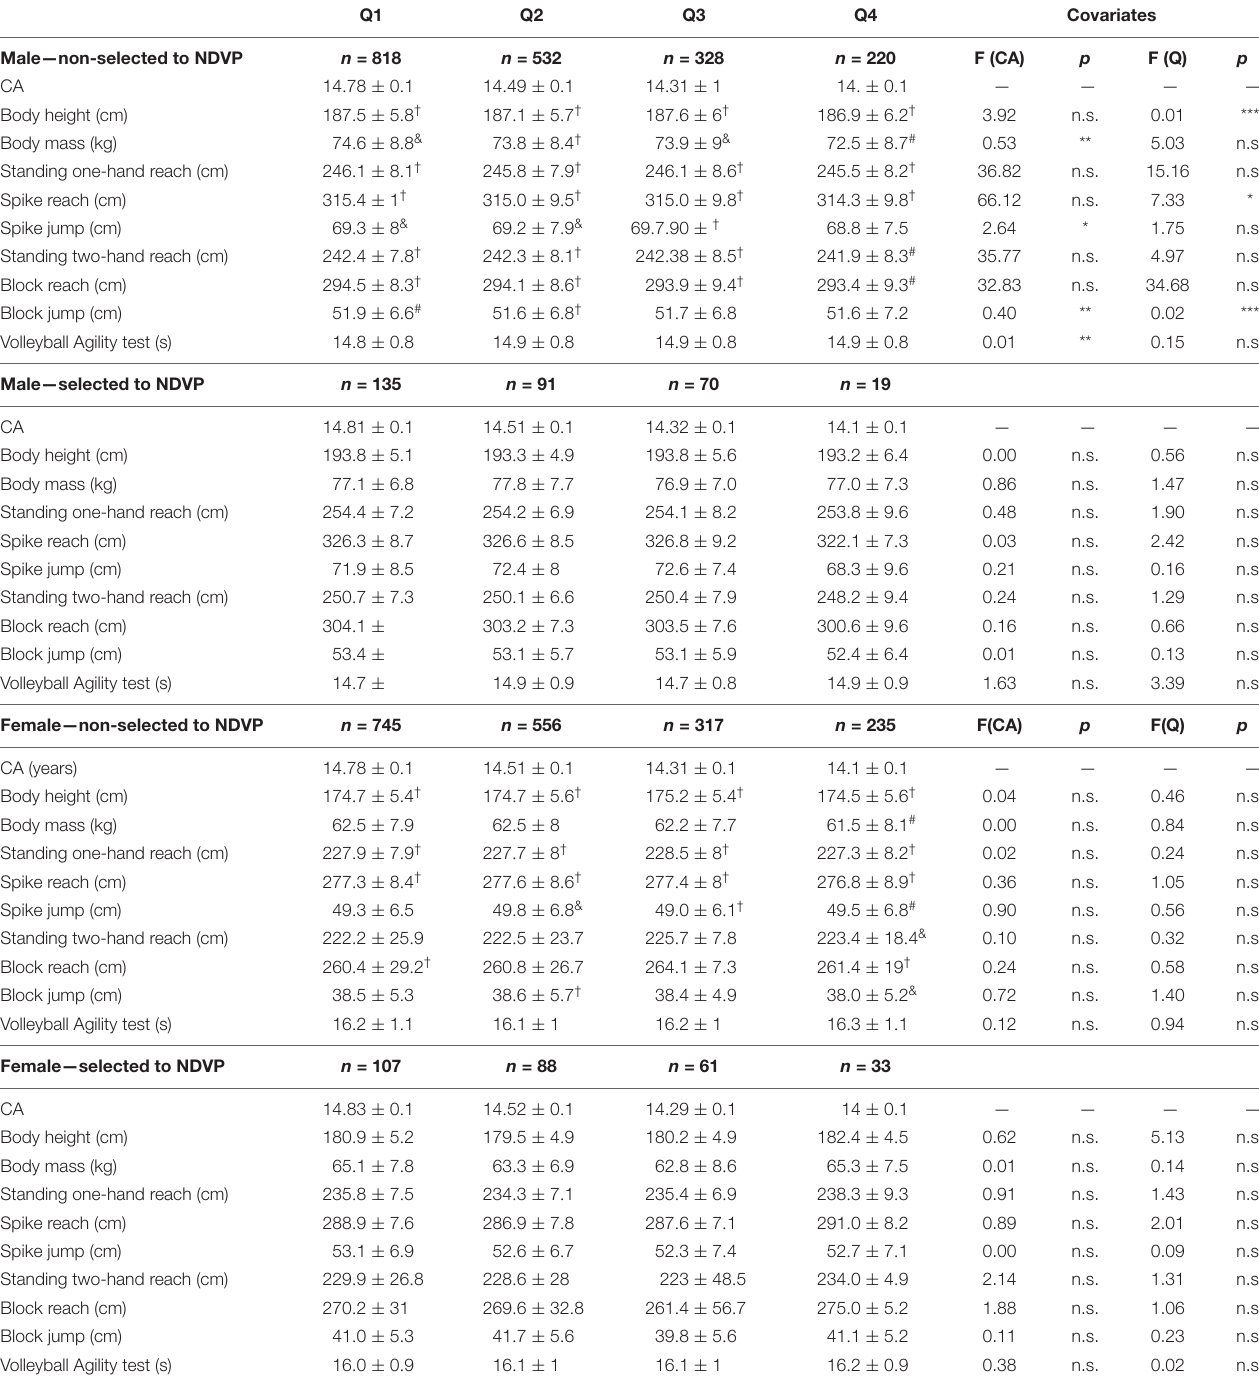
TABLE 2 | Anthropometric variables and motor test results for Polish youth volleyball players across four birth quarters. Q1 Q2 Q3 Q4